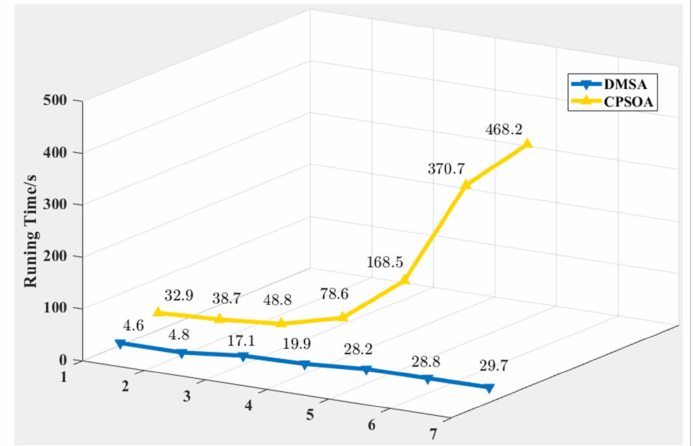
Figure 7. Comparison of scheduling time between DMSA and